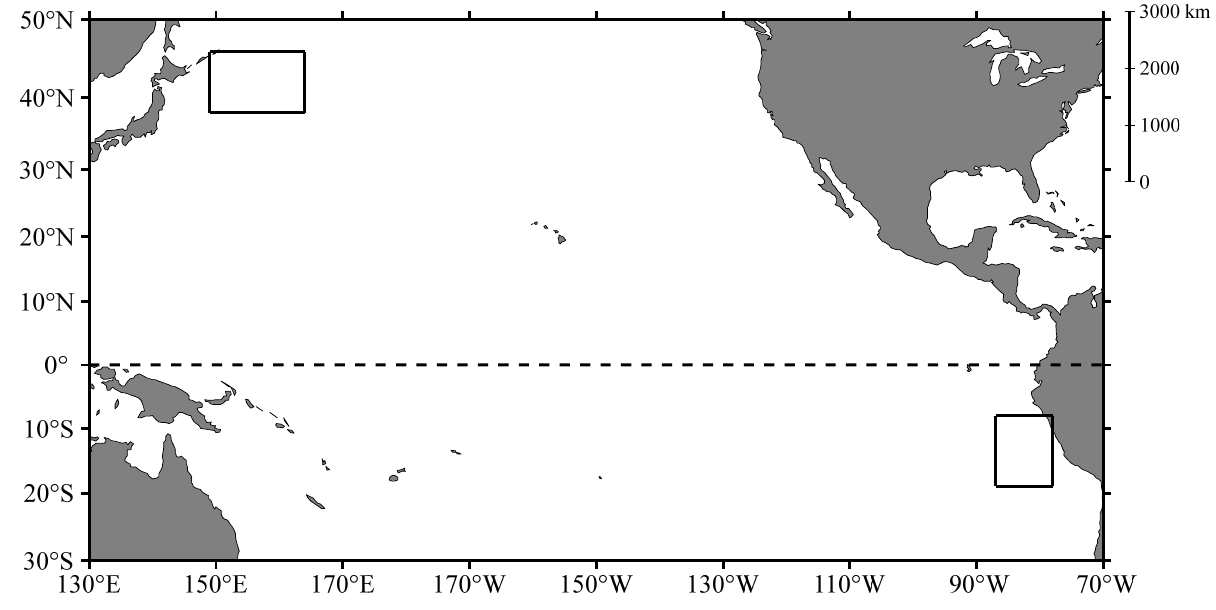
Figure 1. Sampling area of Ommastrephes bartramii and Dosidicus gigas in the Pacific Ocean. Table 1. Sample size (total number) of Ommastrephes bartramii and Dosidicus gigas among years and sexes.